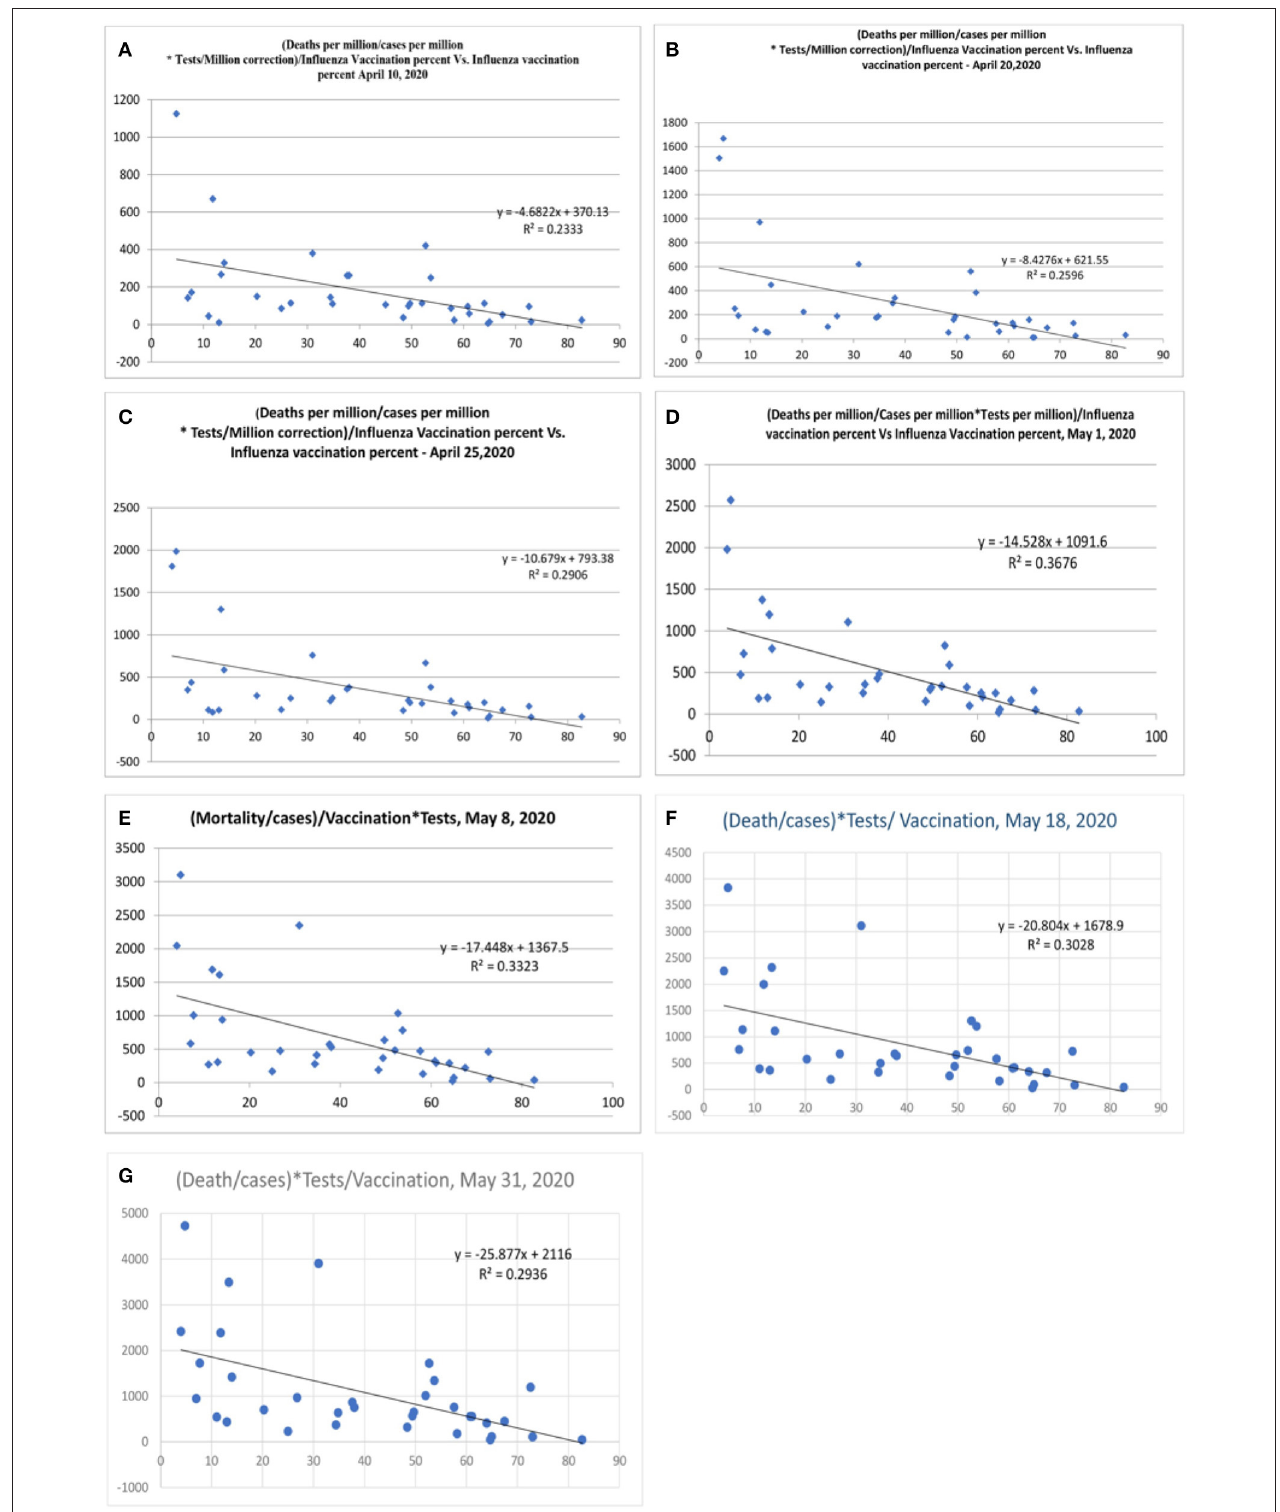
FIGURE 5 | Correlation between influenza vaccination percentage (age ≥ 65 years), vs. [(Deaths/million)/Cases per million]/Vaccination after correction for tests performed per million [ (A) , April 10, 2020, (B) April 20, 2020, (C) April 25, 2020, (D) May 1, 2020, (E) May 8, 2020, (F) May 18, 2020, and (G) May 31, 2020].